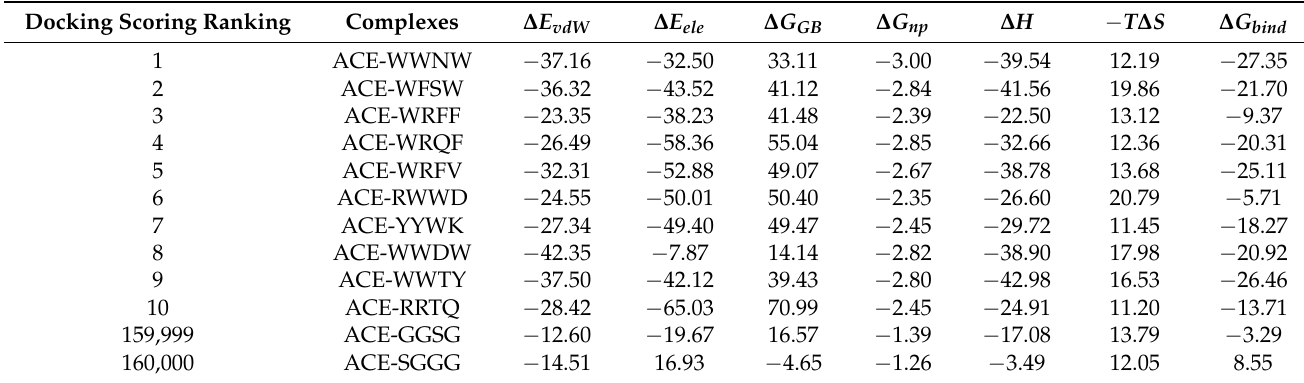
Table 2. Binding free energies of the top 10 and the last 2 ACE–tetrapeptide complexes calculated by the AS-GBIE